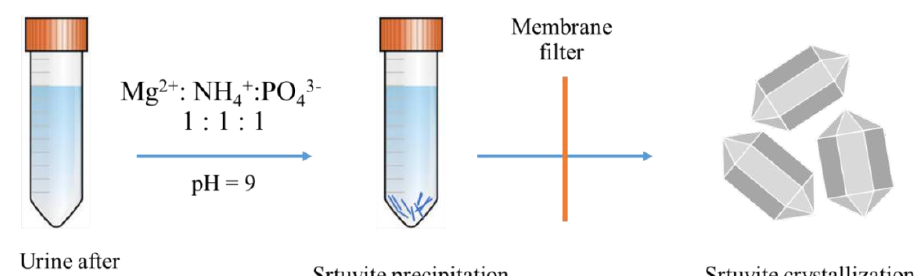
Figure 8. Image of struvite crystallization .